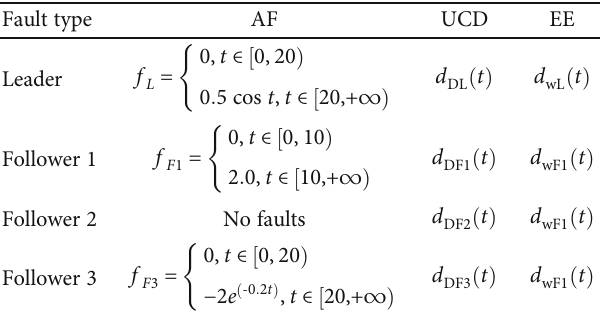
Figure 8: UAV formation both-way communication Table 1: Fault injected strategy.